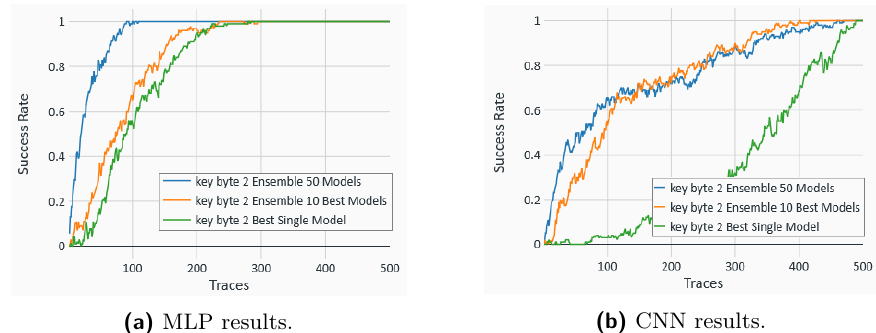
Figure 11: Success rate for ASCAD for the Hamming weight leakage model.